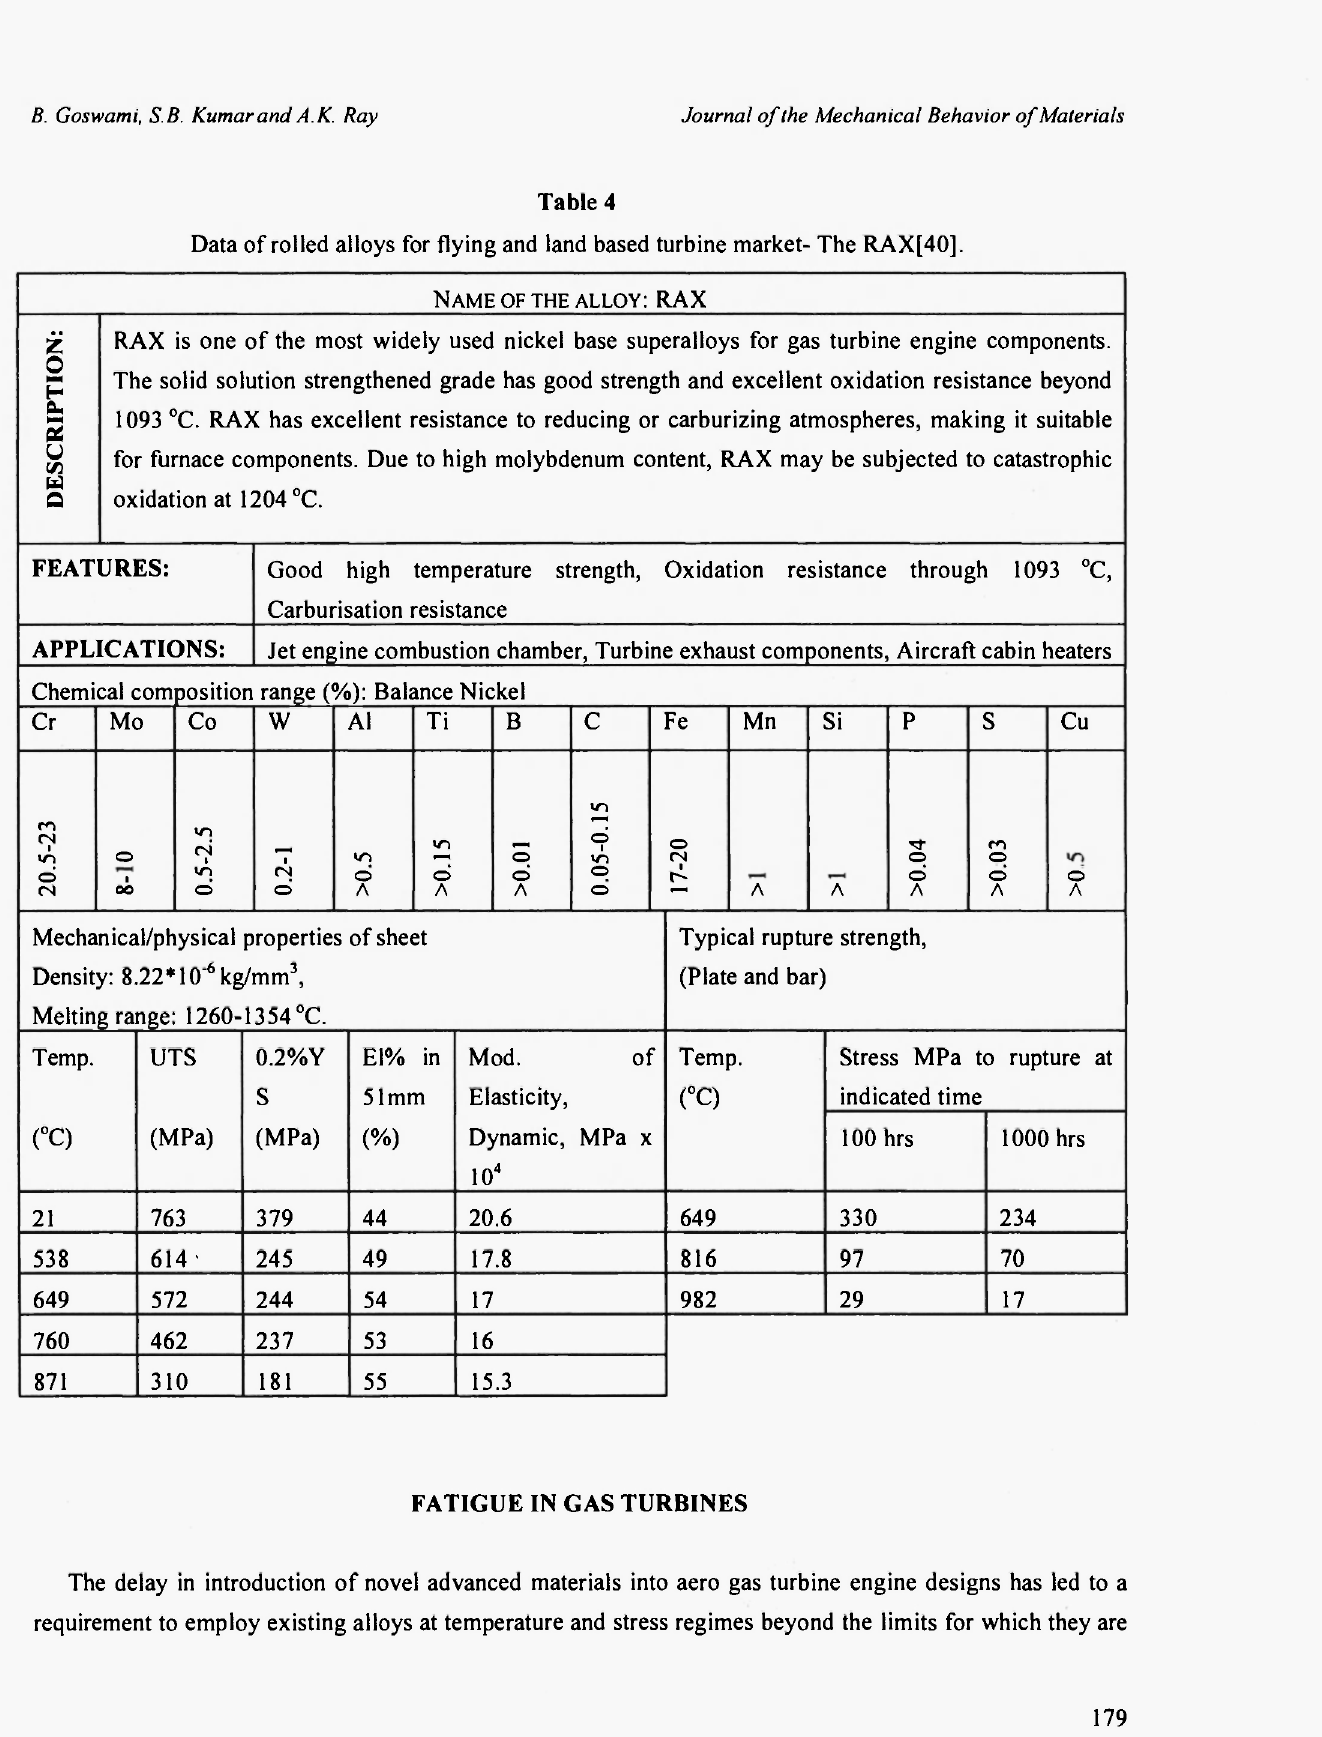
Data of rolled alloys for flying and land based turbine market- The